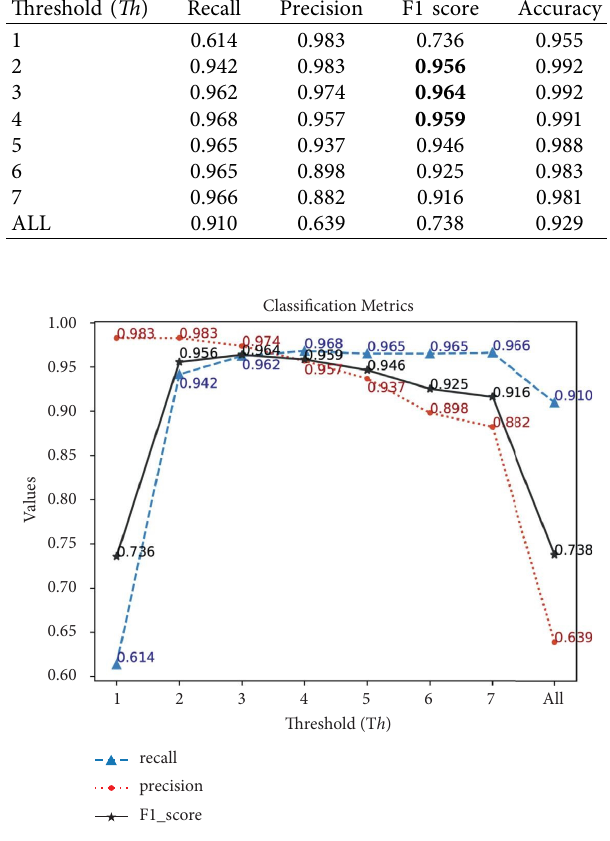
Figure 6: Classifcation metrics results according to diferent thresholds. Table 5: Evaluation results of TSHD using segmentation metrics. Segmentation